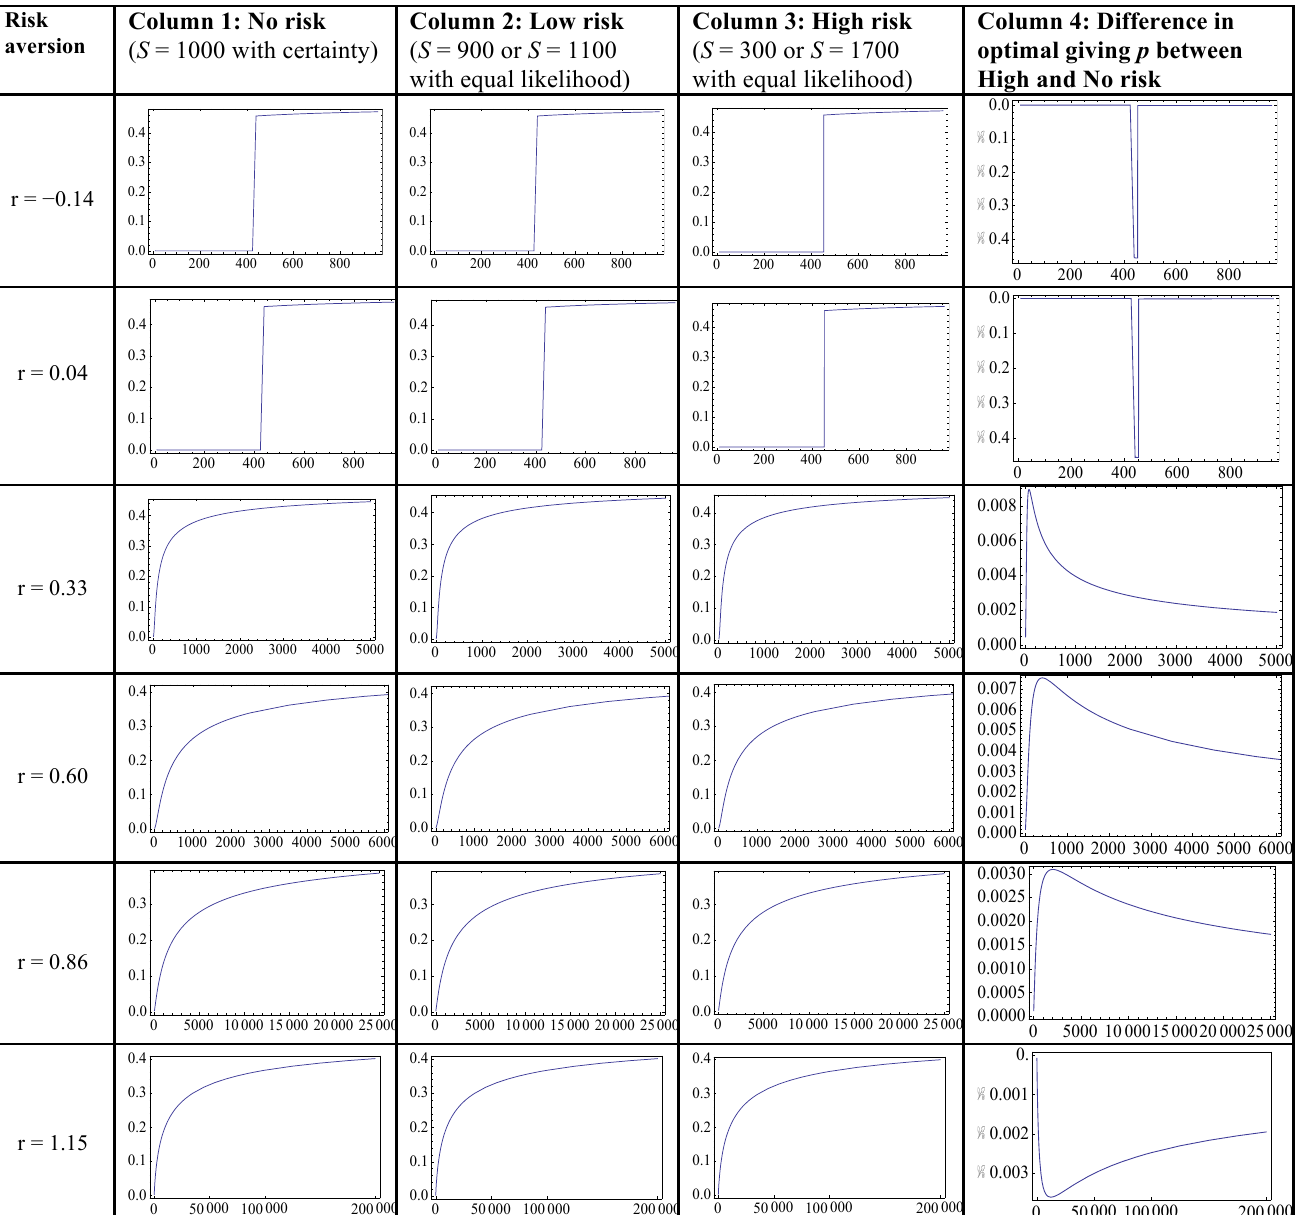
Figure A.3. Effect of risk on acceptance threshold in the Ultimatum